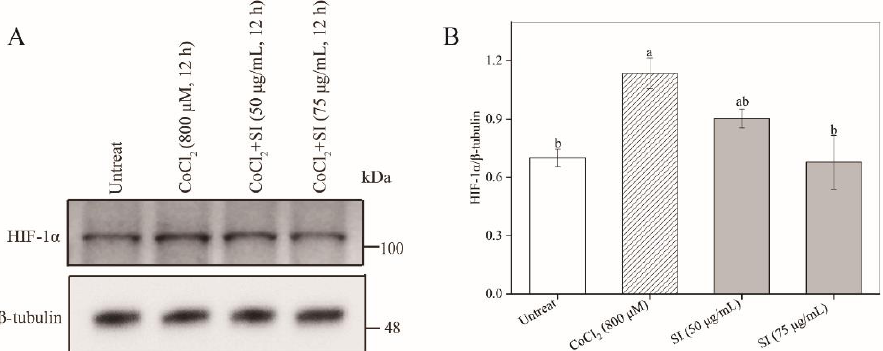
Figure 2. The effects of CoCl 2 and SIs on the expression level of HIF- 1α. ( A ) Western blot analysis of HIF- 1α protein. ( B ) The relative expression level of HIF- 1α protein. Means with different small letters were significantly different ( p < 0.05).